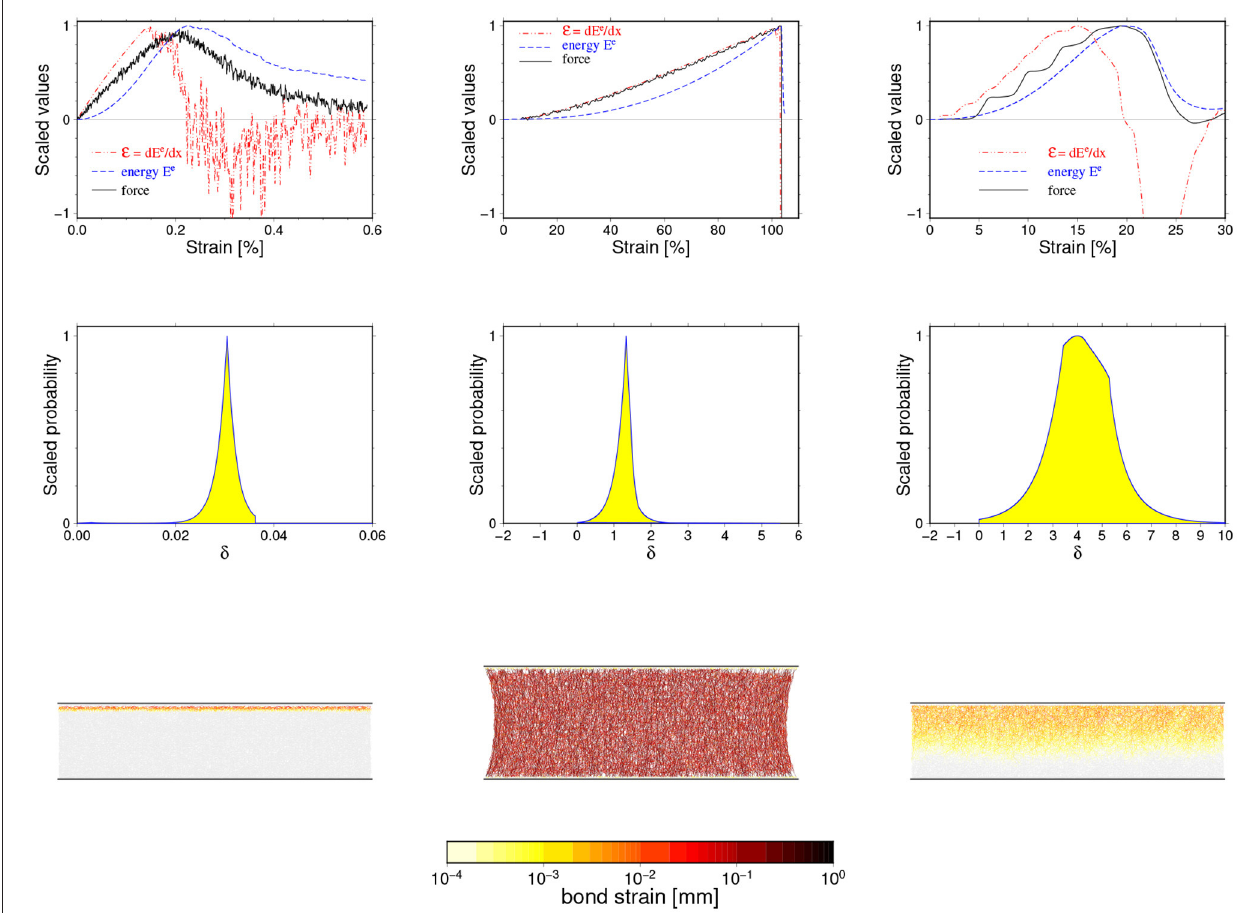
FIGURE 6 | Three types of noise encountered in performed simulations: numerical noise (left column), statistical fluctuations (middle column), and disturbances due to additional physical processes (right column). The F ( x ), E ( x ), and E e ( x ) curves are shown in the uppermost row, the corresponding a posteriori probability distributions for δ x parameter in the middle one, and selected snapshots of samples micro-structures in the lower-most row. The snapshots show the inter-particle bonds strains and use the same color scale. See text for detailed